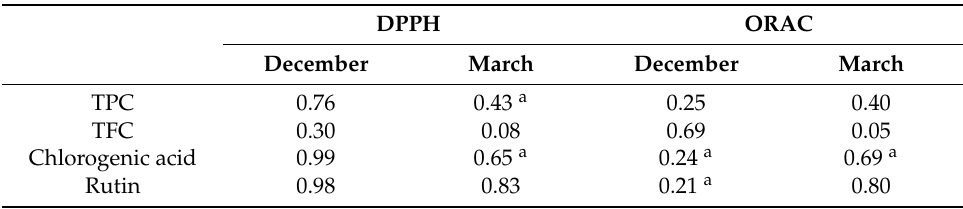
Table 4. Correlation between the total phenolic content (TPC), total flavonoid content (TFC), chlorogenic acid content, rutin content and antioxidant capacities by free radical capture method DPPH (2,2-diphenyl-2-picrilhidrazil) and the ability method removing oxygen radicals (ORAC).